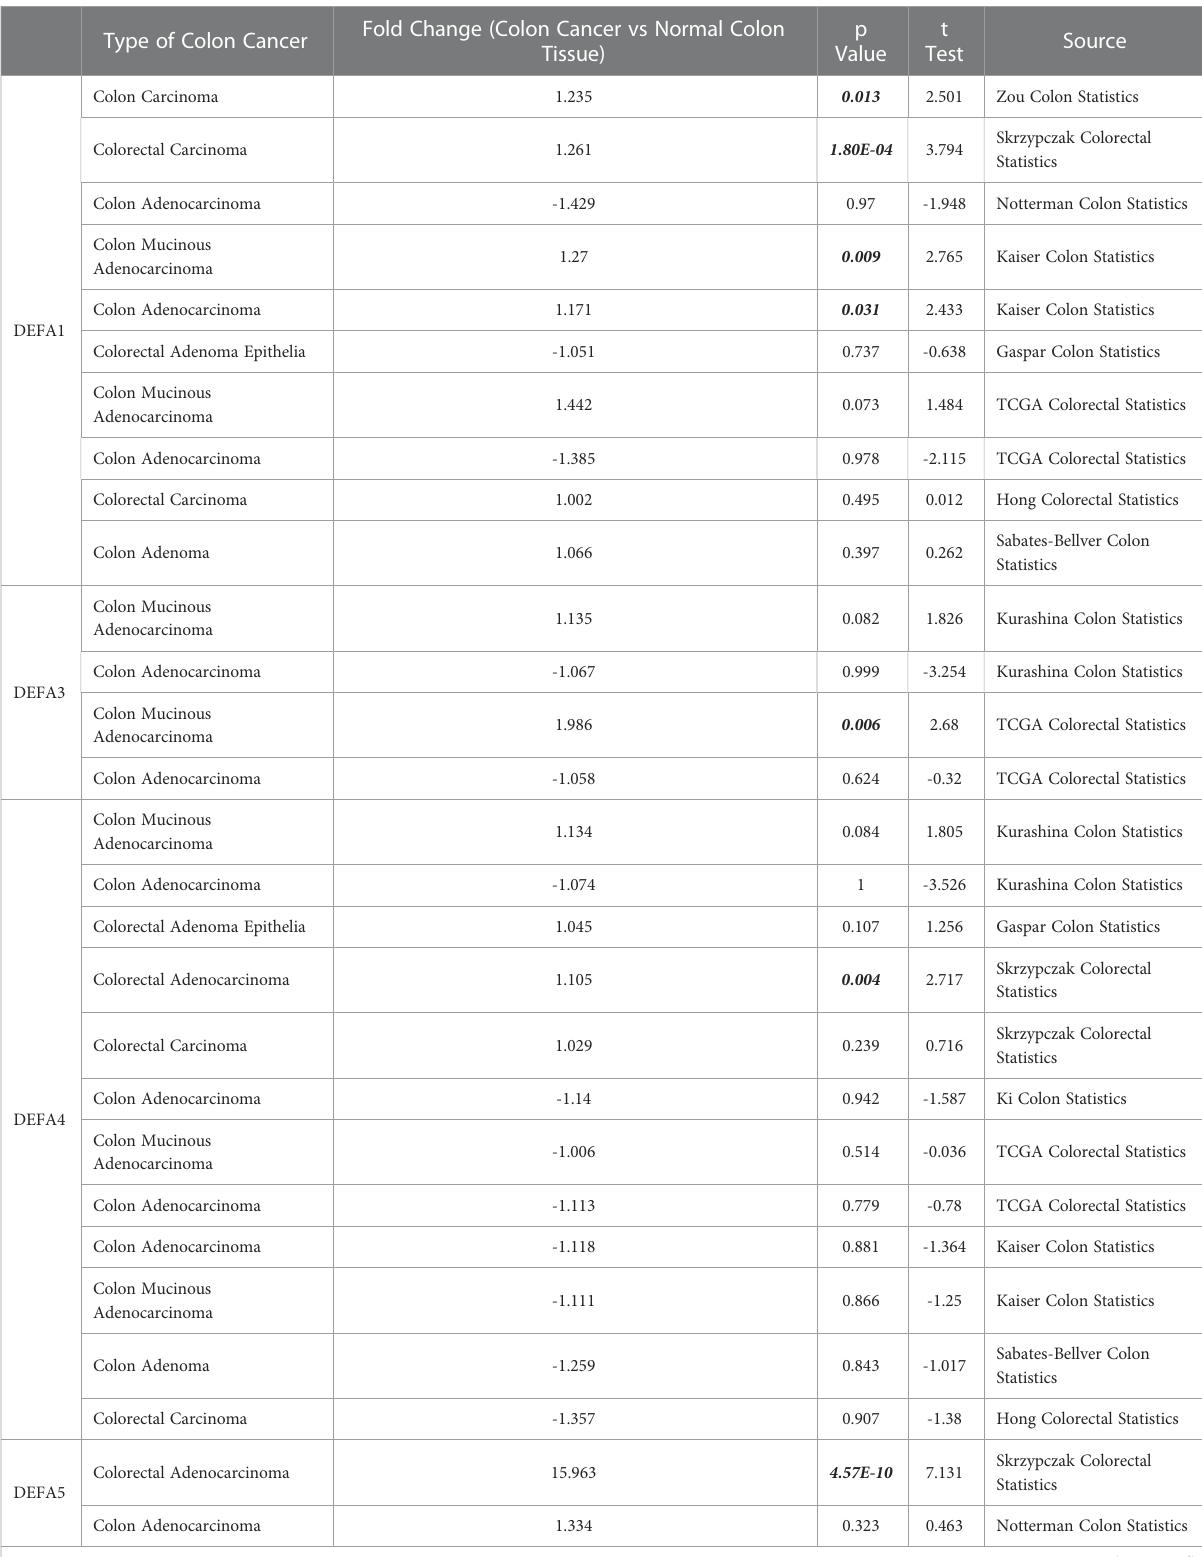
TABLE 1 The fold changes of DEFAs expression in transcription levels between varied types of CRC and normal colorectal tissues (Oncomine